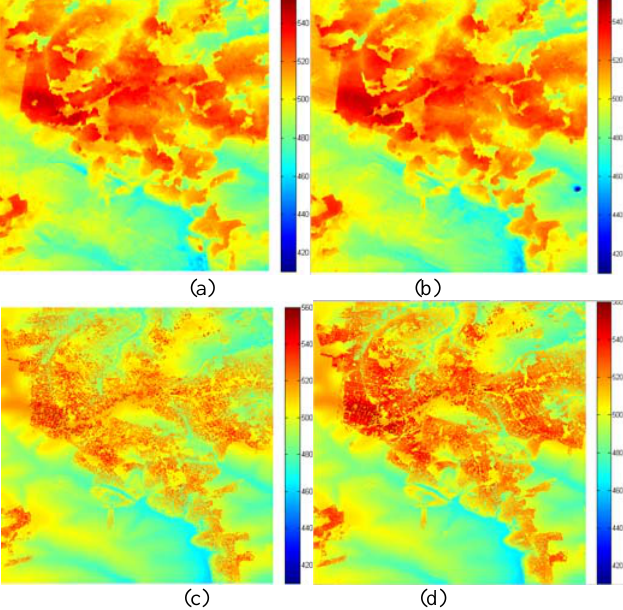
Figure 2. DSMs of the test data (a) DSM-2008, (b) DSM-2009, (c) DTM (LiDAR-2006 last pulse, (d) DSM (LiDAR-2006 first pulse)